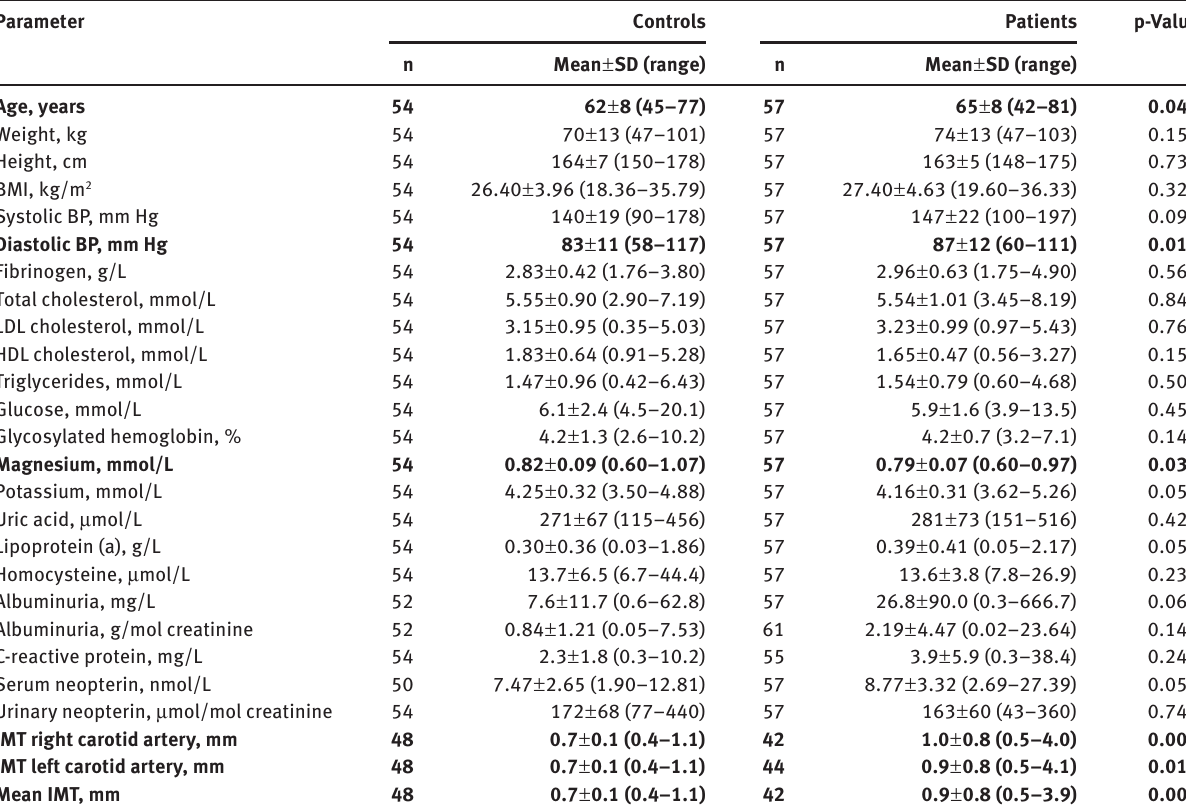
Table 3 Distribution of clinical and laboratory parameters in postmenopausal patients and